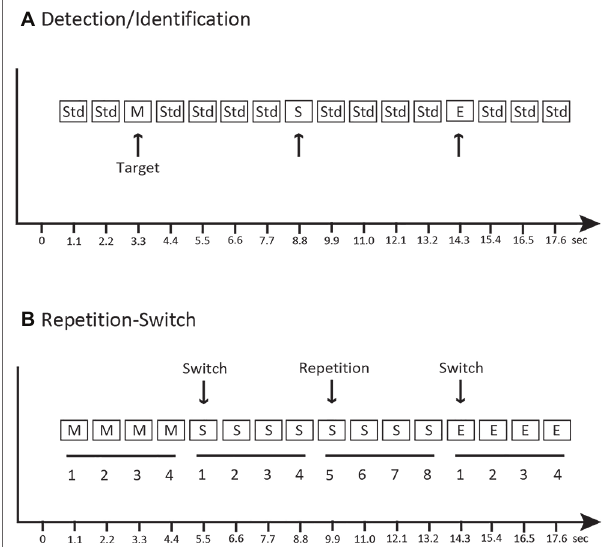
FIGURE 2 | Schematic of the experimental paradigm. (A) Detection and Identification conditions: music (M), speech (S), and environmental (E) sounds were randomly dispersed with a complex tone (1,000 Hz, “Std”). The target sounds are indicated with an arrow and were the same sounds in both conditions, with the difference being whether the key was pressed when any sound was detected vs. pressing a specific key to identify the category of sound. (B) Repetition-Switch condition: categories of music, speech, and environmental sounds were presented randomly, in groups of four repetitions. The arrow indicates a switch of category and a repeat of category. The x -axis indicates